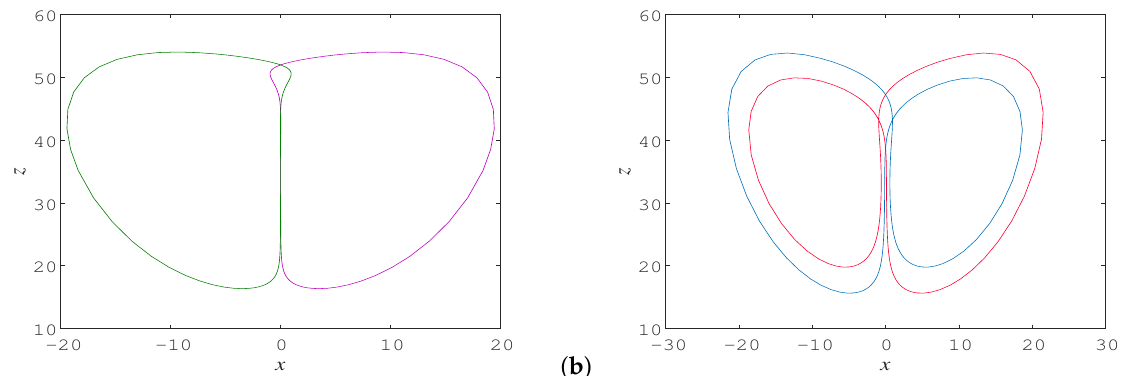
Figure 8. Coexisting periodic attractors of system (2) in ( x , z ) plane: ( a ) ( a , b , c , d ) = ( 35,0.42, 35,10 ) and ( b ) ( a , b , c , d ) = ( 35,1.5,35,10 ) .